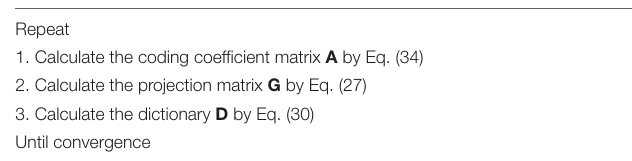
ALGORITHM 2 | The MBCC algorithm.